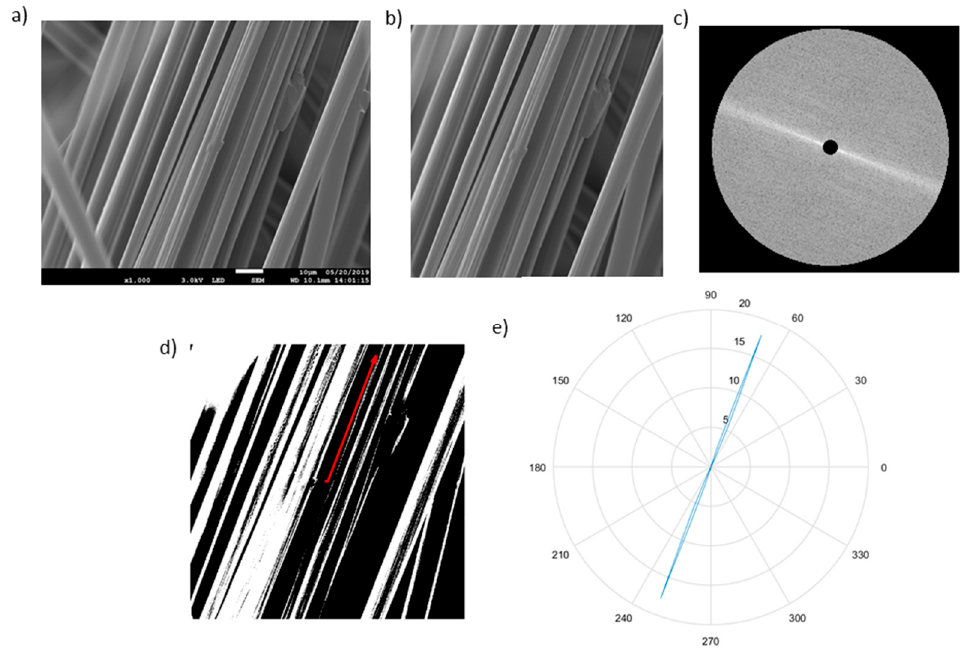
Figure 1. Example of performed analysis on SEM micrograph captured at 2000 magnification ( a ) by FFT method, trimming into square image ( b ), converting into frequency space with polar coordinate ( c ), indication eigenvectors (in red) ( d ), and polar fibre orientation distribution ( e ).